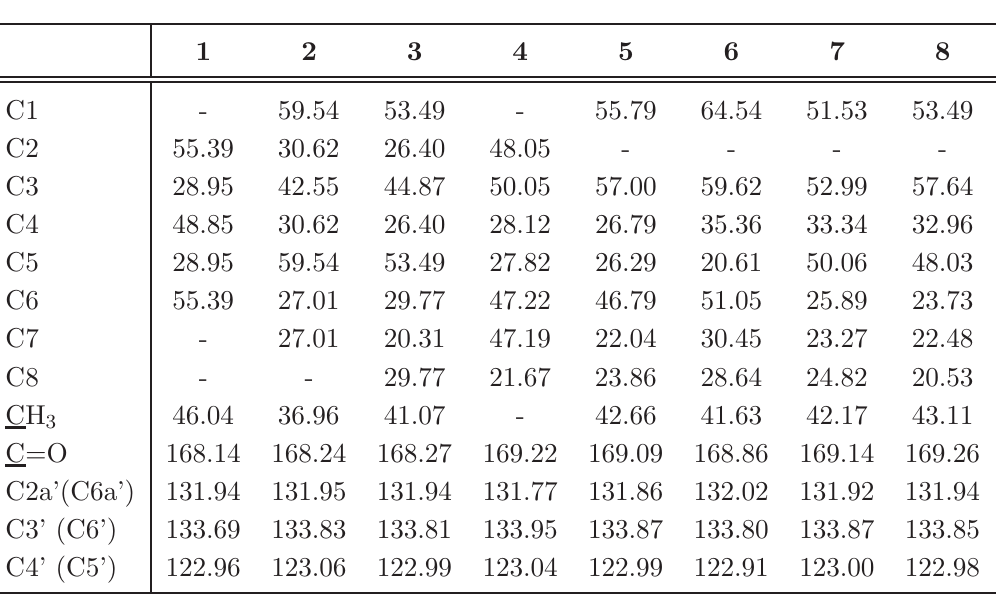
Table 4 13 C Chemical shifts ( δ , ppm) for compounds 1-8 in CDCl 3